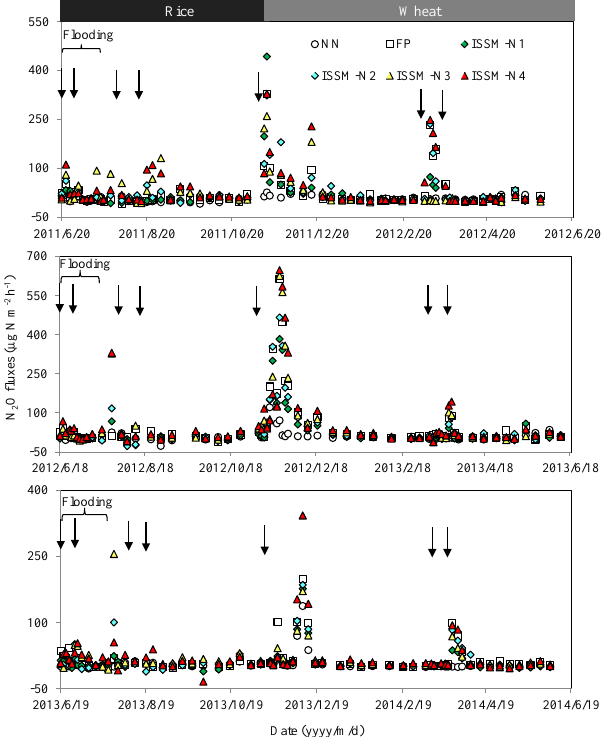
Figure 4. Seasonal variation of nitrous oxide (N 2 O) fluxes from rice-wheat rotation cropping systems in three annual cycles over the period 2011–2014. The black and gray part in the figure separates different growth periods. See Table 1 for treatment codes. The solid arrows indicate